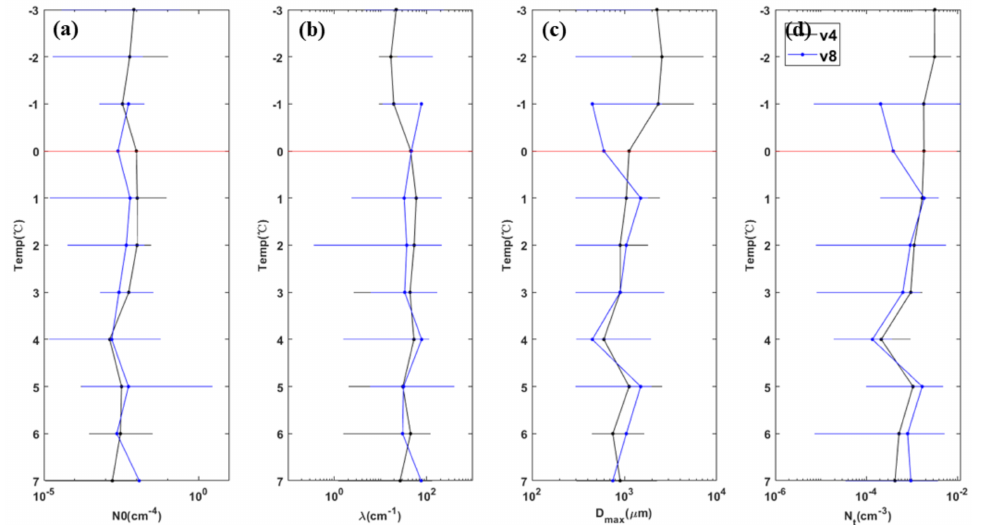
Figure 16. The parameters of 24 August 2019, ( a ) intercept ( N 0 ), ( b ) slope ( λ ), ( c ) the maximum particle size ( D max ), ( d ) the total particle concentration ( N t ) The red line is the 0 ◦ C